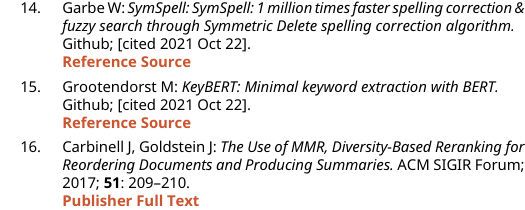
14. GarbeW: SymSpell:SymSpell:1milliontimesfasterspellingcorrection& fuzzy search through Symmetric Delete spelling correction algorithm. Github; [cited 2021 Oct